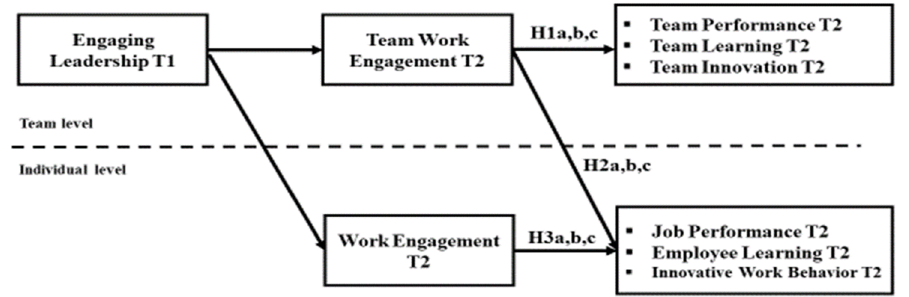
Figure 1. Research Model of Engaging Leadership, Work Engagement, and Job Performance Relationship at the Individual and Team Level.